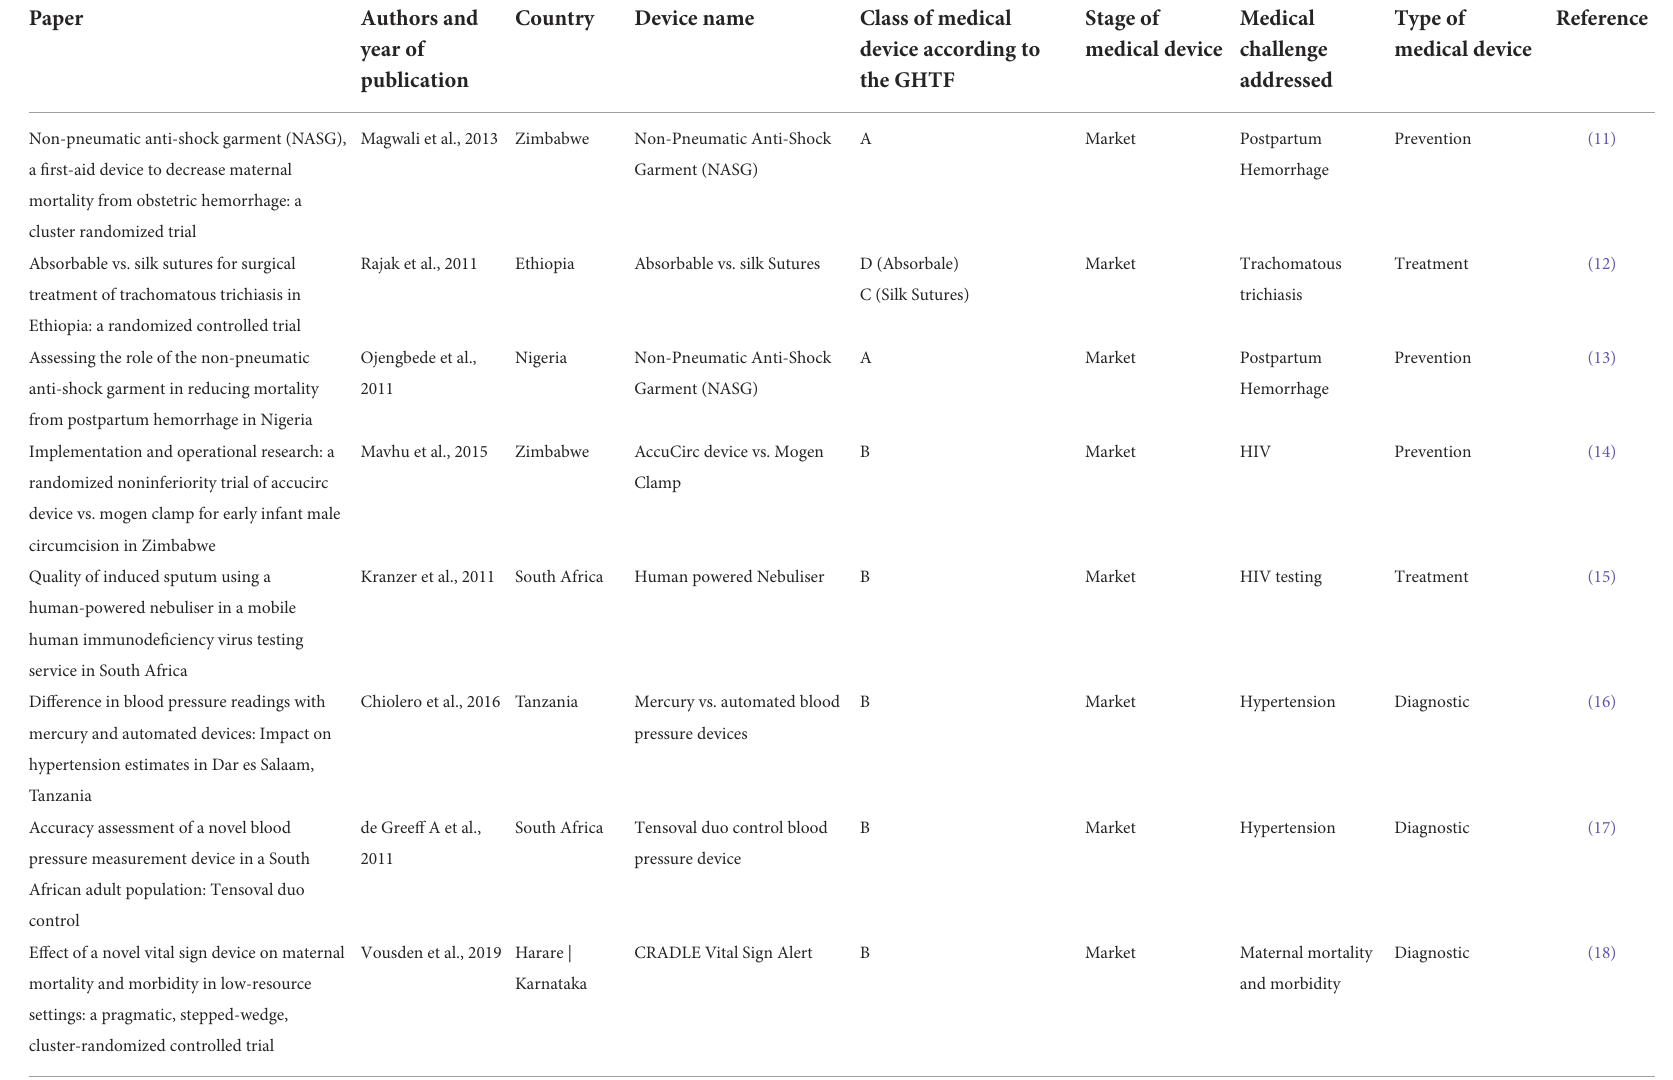
TABLE 2 Listing of some of the medical devices’ clinical trials that have taken place in Africa showing the year of publication, the country where the trial took place, the device name, the class of the device according to the GHTF, the stage of the device under trial, the medical challenge being addressed and the type of medical